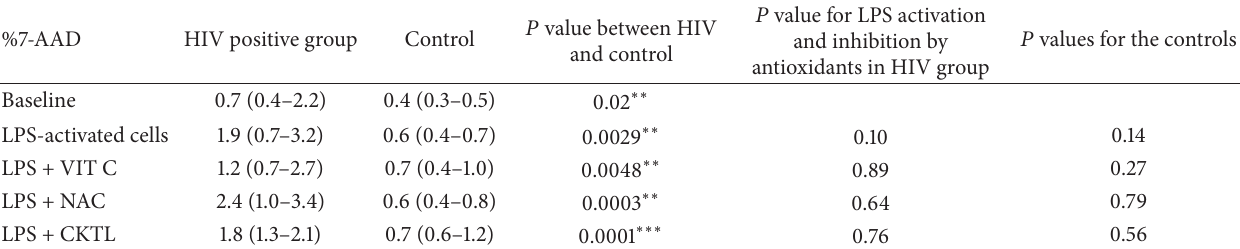
Table 4: The % annexin V+/7-AAD+ staining of the HIV positive and HIV negative